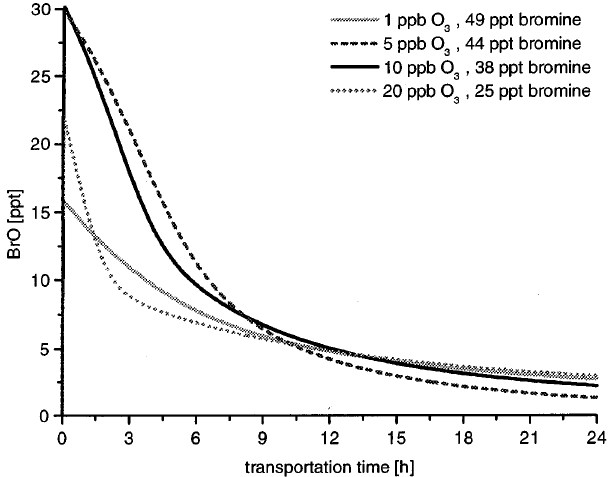
Fig. 15. Model calculation: development of BrO with time for various mixtures of O 3 depleted air containing 25 ppt Br 2 with background air containing 40 ppb O 3 and